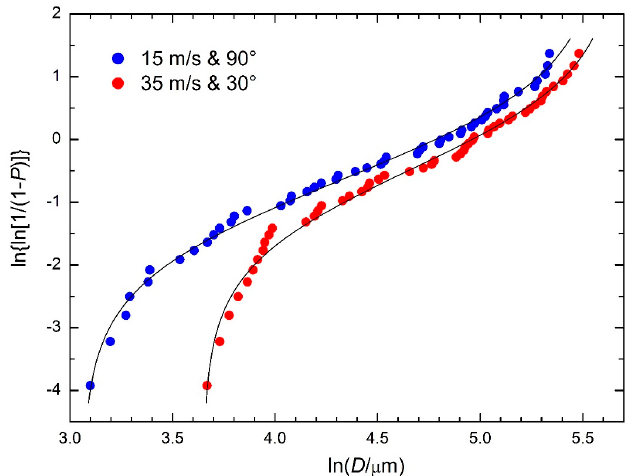
Figure 11. Weibull plots of defect sizes in soda lime glass due to the air stream with sand particles at given velocities and impact angles [15].